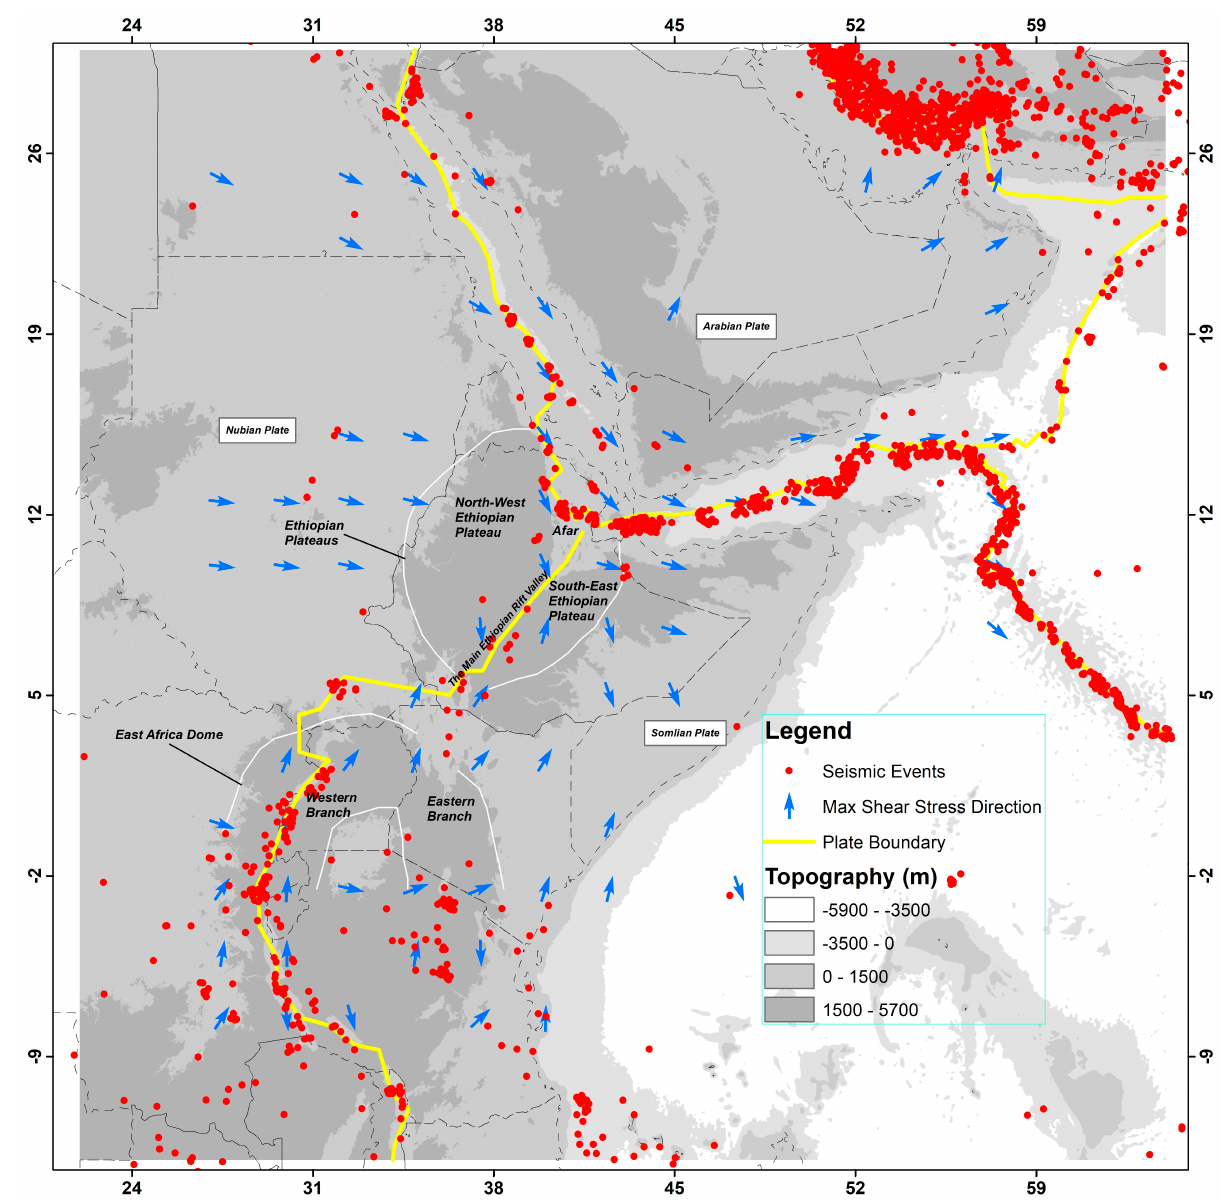
Figure 2. Plate boundaries and seismic events of the study area. Red dots are seismic events from 1964–2017 (http://www.isc.ac.uk/isc-ehb/search/catalogue/, accessed on 10 March 2021), the blue arrows are the maximum shear stress direction of WSM 2016, the topography data are derived from ETOPO1 digital data (https://www.ngdc.noaa.gov/mgg/global/relief/ETOPO1/, accessed on 24 March 2021), and thick yellow lines are the boundaries of the plates from model PB2002 [26].